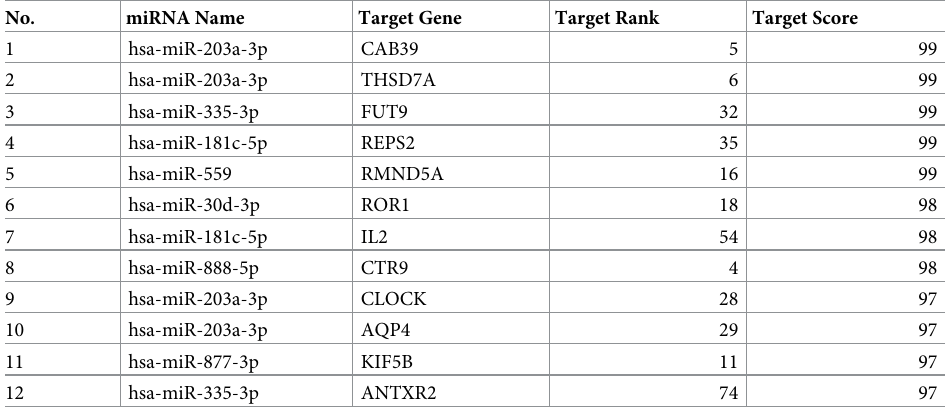
Table 1. The top differentially expressed miRNAs and their target genes based on miRbase target scores. No. miRNA